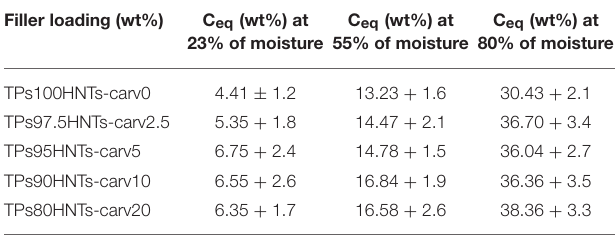
FIGURE 7 | Release fraction of carvacrol (wt%), as function of contact time (h) for TPs97.5HNTs-carv2.5 ( ), TPs95HNTs-carv5 ( ), TPs90HNTs-carv10 ( ), TPs80HNTs-carv20 (